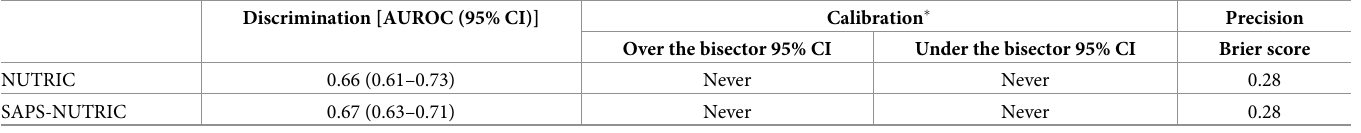
CI, confidence interval. AUROC, area under the receiver operating characteristic curve. � Calibration described as the bisector deviation intervals by the calibration belt method.